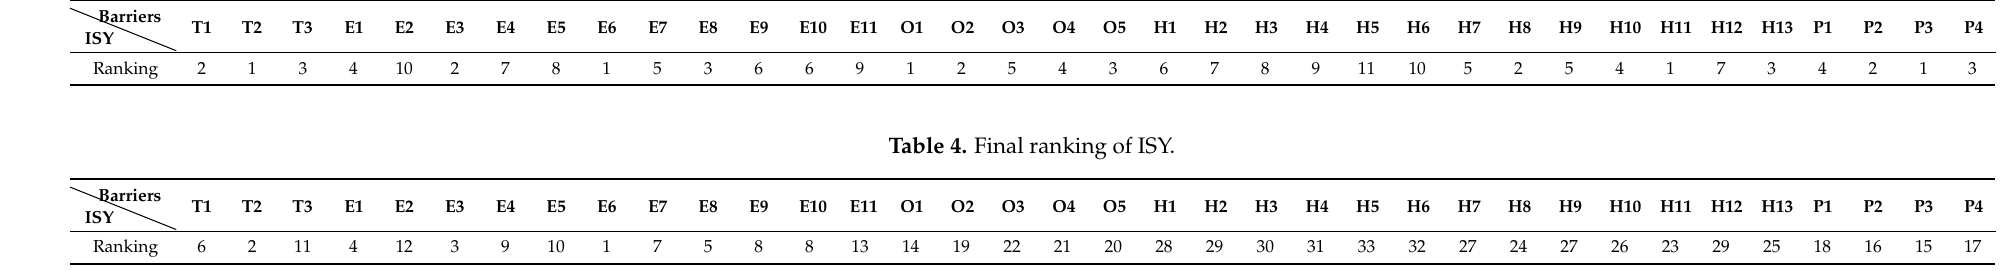
Table 3. Ranking of the ISY barriers in each discipline.